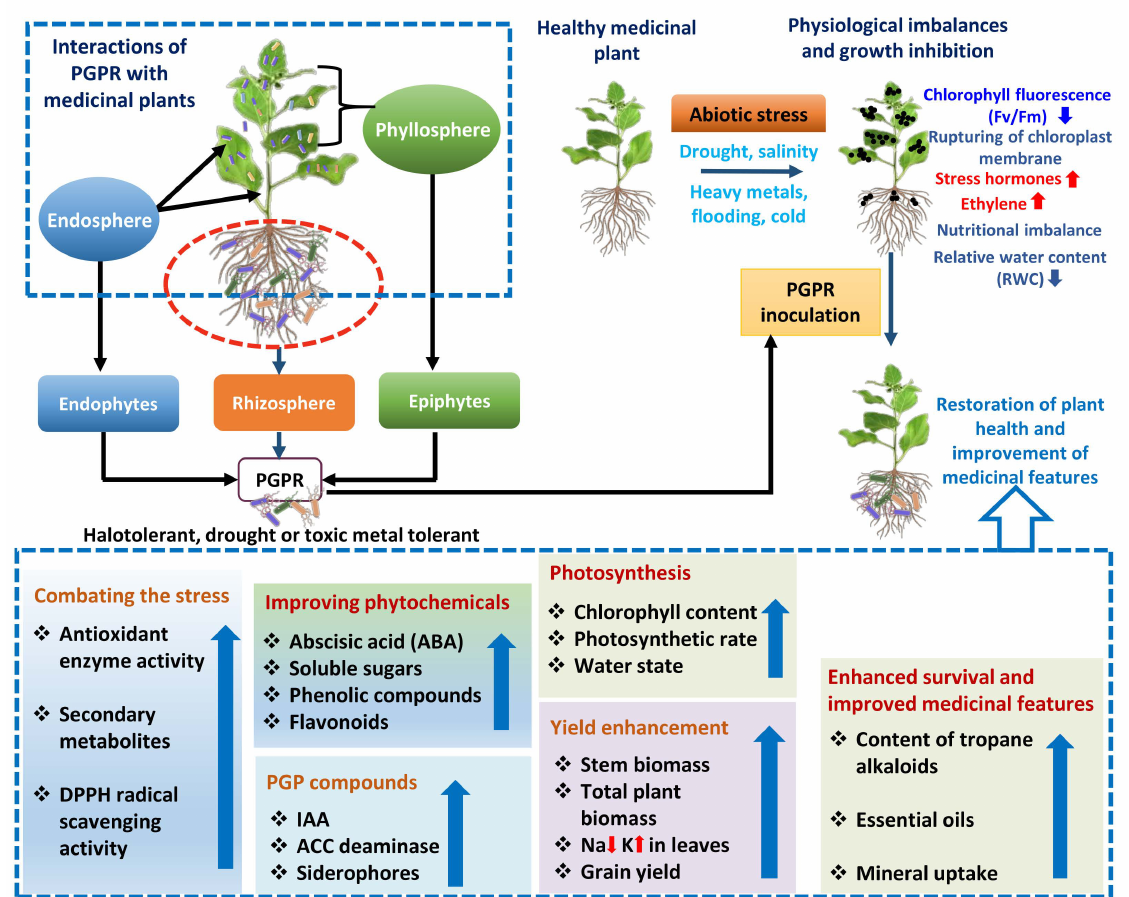
Figure 3. Various outcomes of endophytic, epiphytic and rhizospheric PGPR–medicinal plant interactions and management of abiotic stresses such as drought, salinity and metal toxicity re- sulting in the restoration of health of medicinal plants and overall enhancement in the biological growth, phytochemicals and bio-antimicrobials. PGPR = plant growth promoting rhizobacteria, IAA = indole-3-acetic acid, ACC = 1-aminocyclopropane-1-carboxylic acid (ACC). Bidgoli et al. [218] showed that the yield of essential oil of Rosmarinus officinalis plants was enhanced when the plants were inoculated with rhizobacterial strain P. fluorescens over uninoculated plants, even under salinity stress conditions. The increment in the growth and yield of Mentha arvensis plants was recorded following inoculation with Halomonas desiderata and Exiguobacterium oxidotolerans , even under varying levels (100, 300 and 500 mM) of salts [254]. Generally, PGPR strains significantly increased the yield which, however, varied considerably with variation in salt concentrations. For instance, H. desiderata produced maximum yield at 100 and 300 mM NaCl, whereas E. oxidotolerans showed maximum yield at 500 mM NaCl concentration. Likewise, salt stress alleviation in medicinal plant Sylebum marianum and pepper following inoculation with halotolerant IAA positive P.